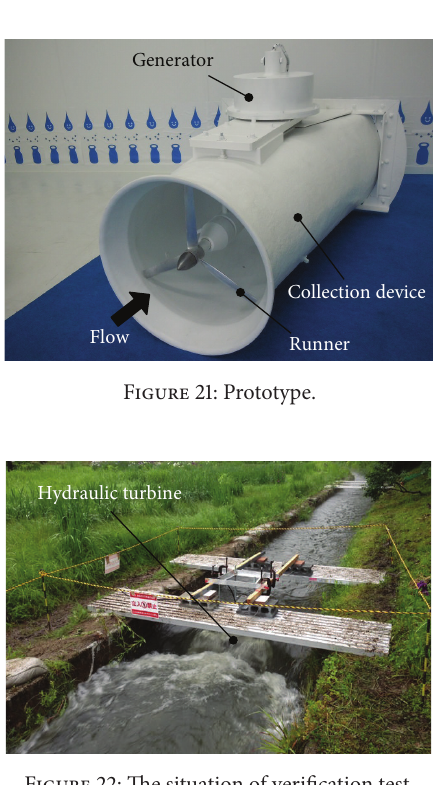
Figure 22: The situation of verification test.